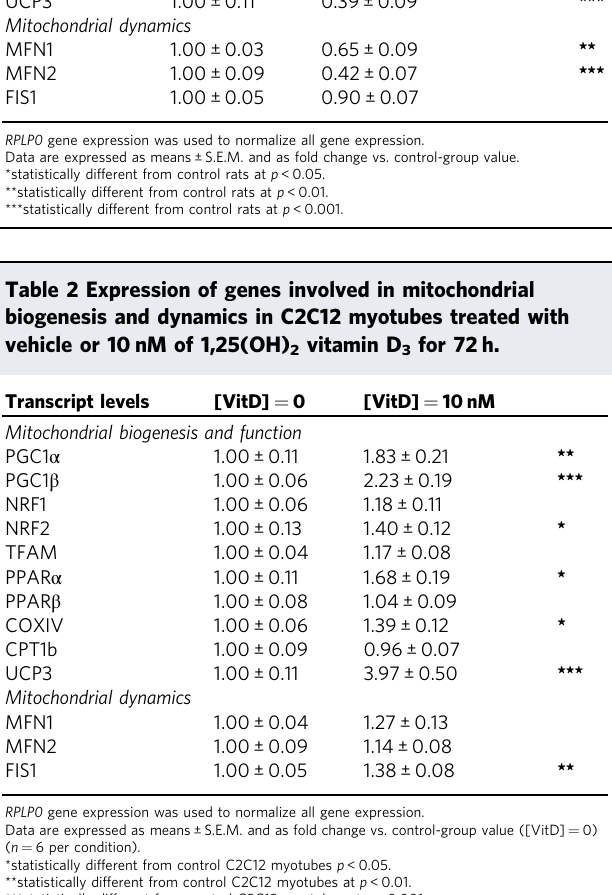
RPLP0 gene expression was used to normalize all gene expression. Data are expressed as means±S.E.M. and as fold change vs. control-group value. *statistically different from control rats at p <0.05. **statistically different from control rats at p <0.01. ***statistically different from control rats at p <0.001.